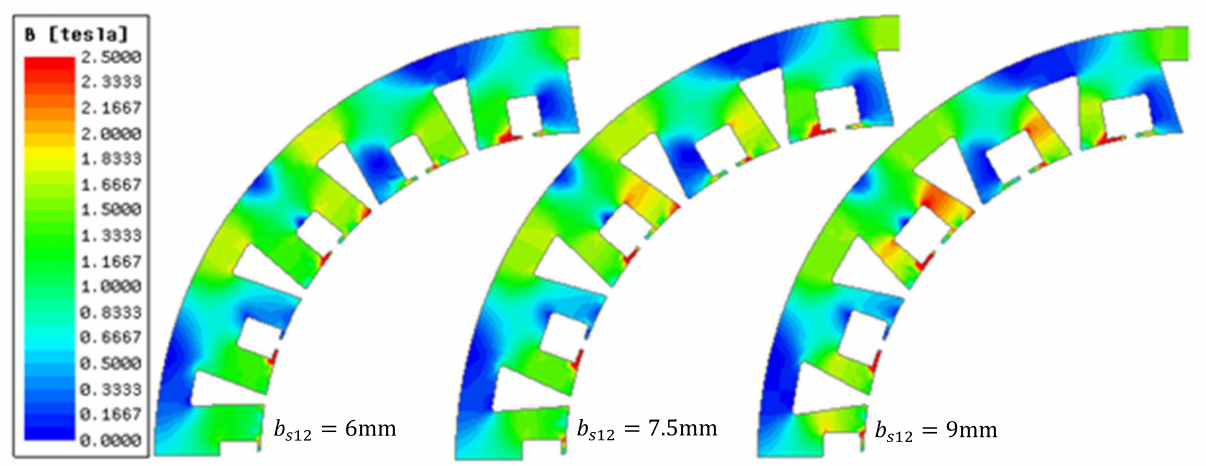
Figure 40. Variation of some key performance characteristics with h s 12 : ( a ) torque and torque ripple and ( b ) stator copper loss and current density.